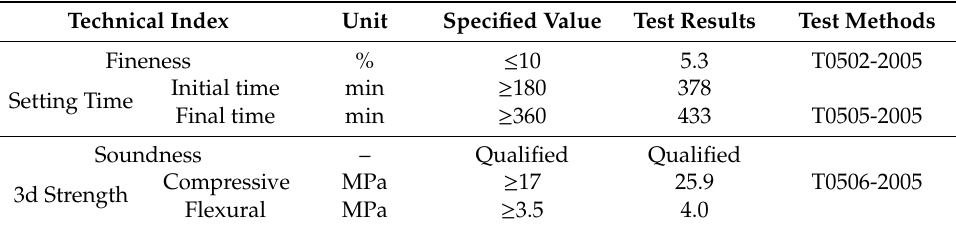
Table 1. Technical indicators of cement.